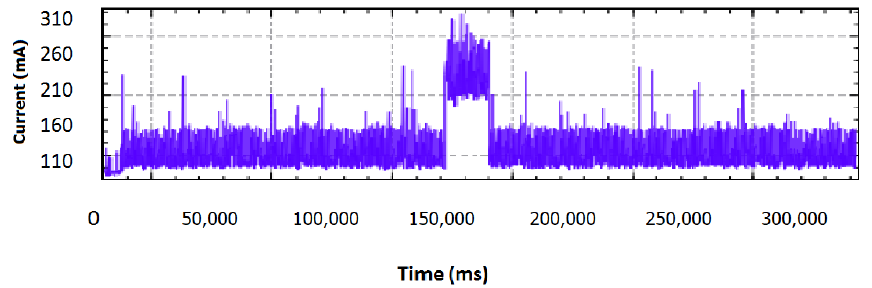
Figure 8. IP camera with infected application